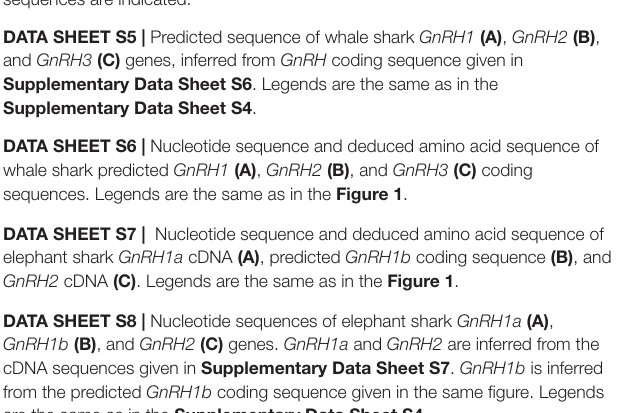
indicated by colored boxed. The exon/intron boundary consensus sequences (GT/AG) are highlighted in red. Initiation (ATG) and stop codons are boxed. Polyadenylation signals are underlined. The identity of the scaffolds containing the sequences are indicated.